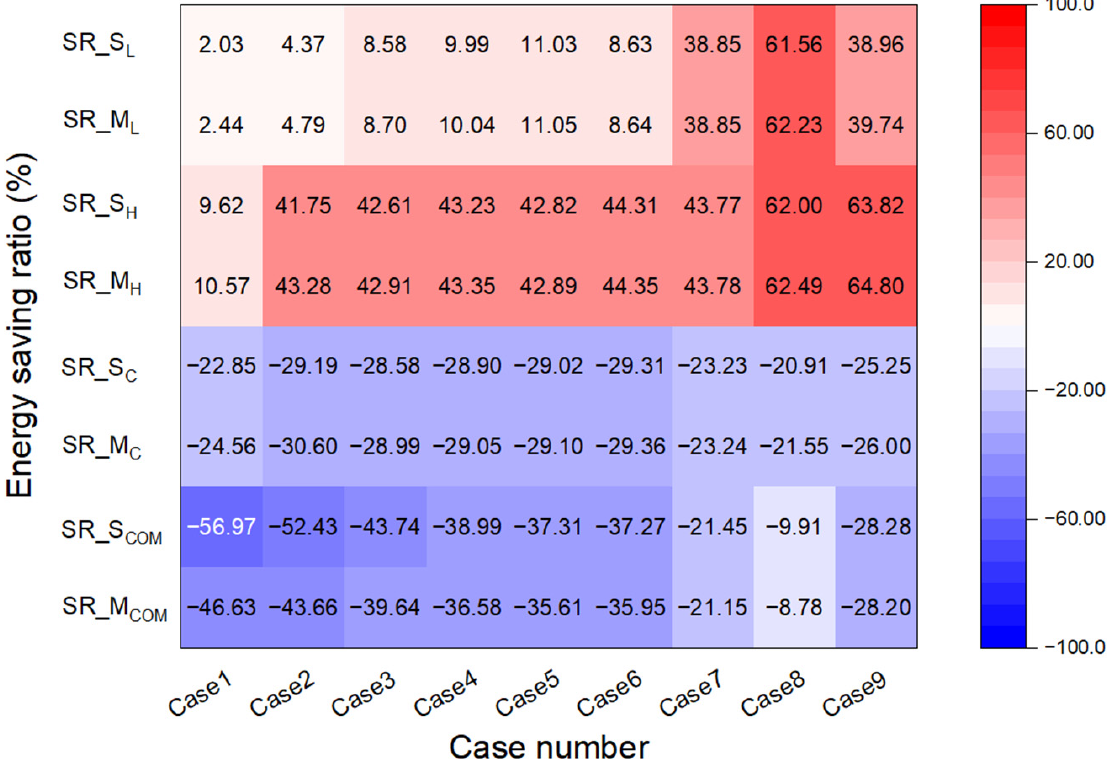
Figure 14. Energy saving analysis of building with different PVSDs in Beijing. (3)